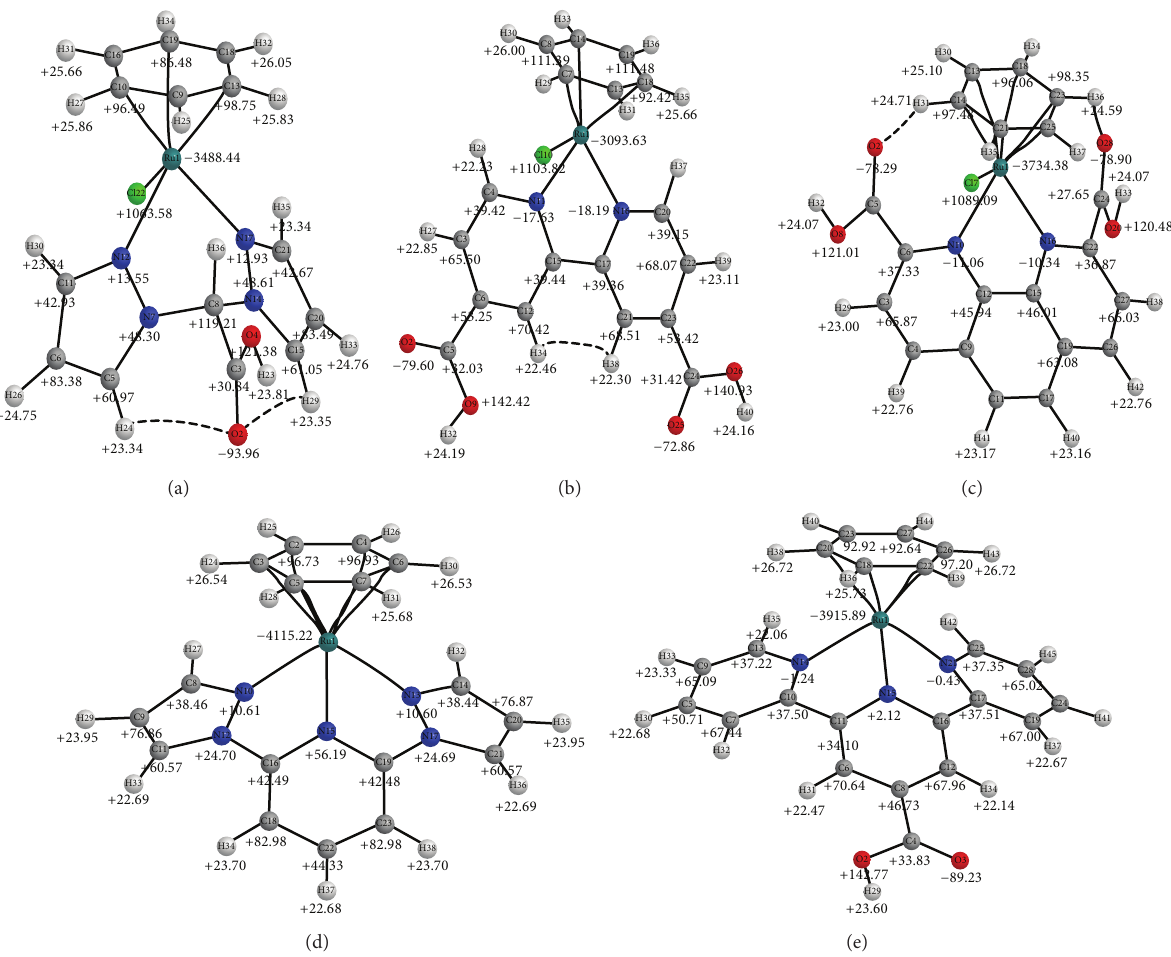
Figure 3: The optimized geometries of the complexes showing the isotropic NMR shielding of selected atoms computed with DGDZVP(Ru) | 6-31+G(d,p).